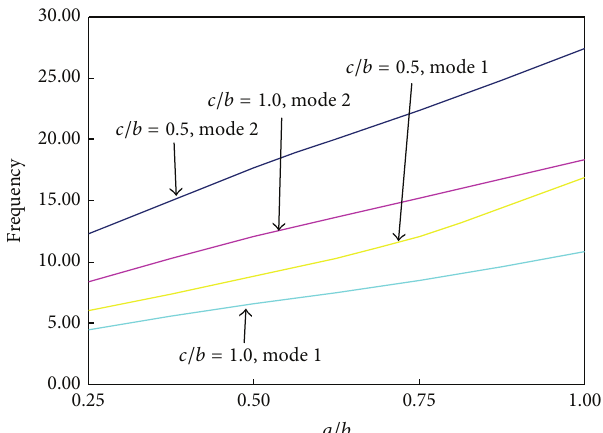
Figure 10: Value of frequency parameter for orthotropic trapezoidal plates for different values of 𝑎/𝑏 and fixed values for 𝛼 = 0.2 , 𝛽 = 0.4 .